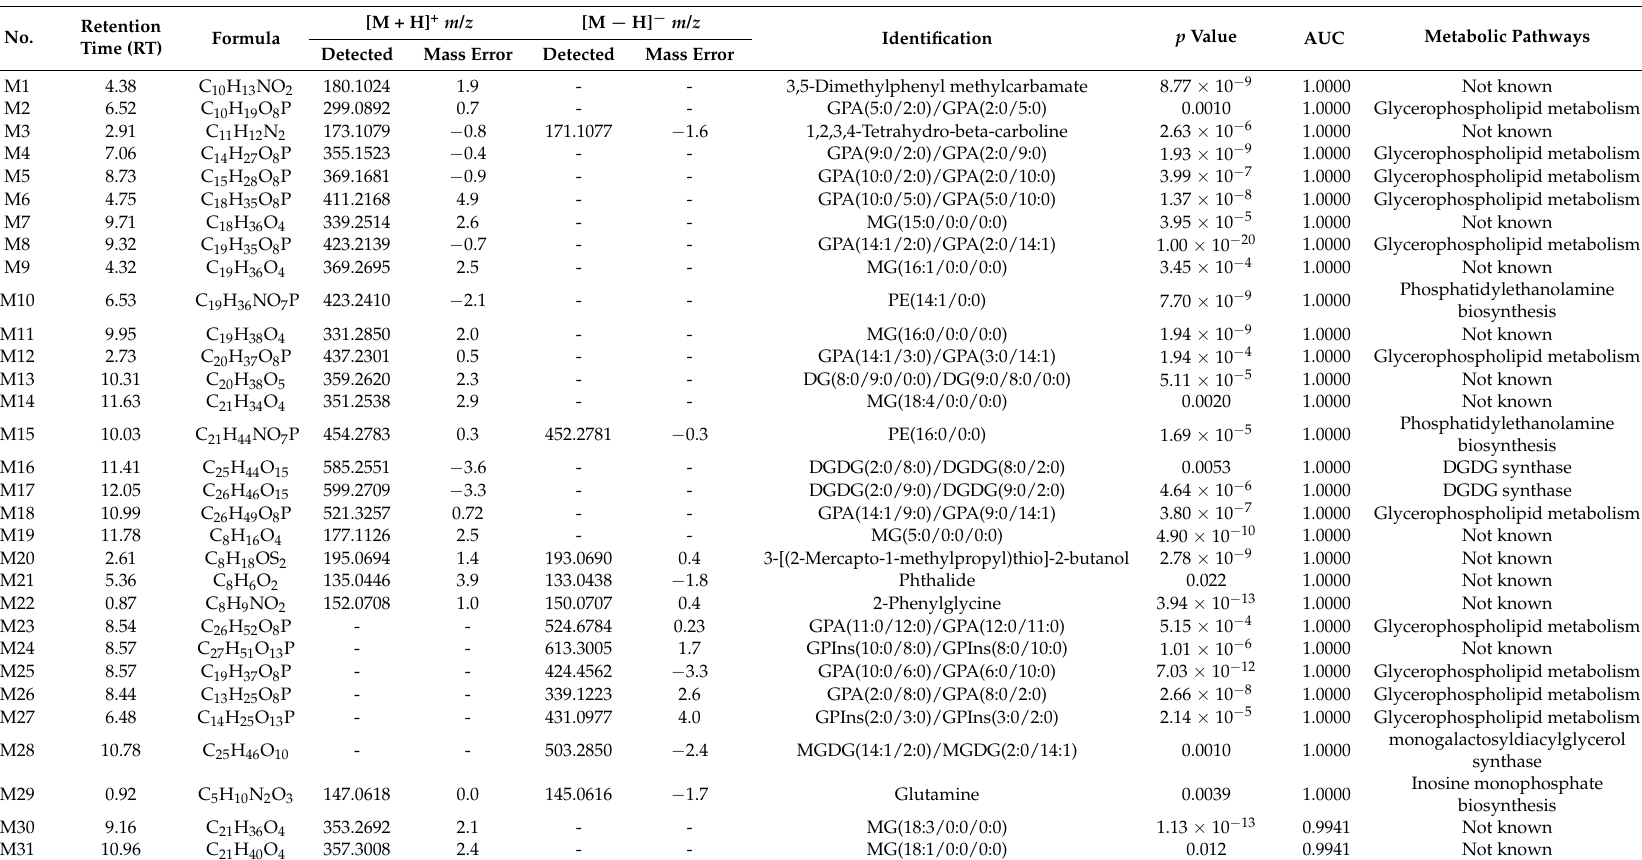
Table 1. Differential primary metabolites between the Citrus reticulate Blanco and Citrus aurantium L. group profile in positive and negative ion modes. GPA (glycerophosphatidic acid); MG (monogalactosyl); PE (phosphatidylethanolamine); DG (diacylglycerol); GPEtn (glycerophosphoethanolamine); PC (phosphatidylcholine); GPIns (Glycerophosphatidylinositol), GPSer (Glycerophosphatidylserine acid), GPGro (Glycerophosphatidylglycerol); UMP (Uridine